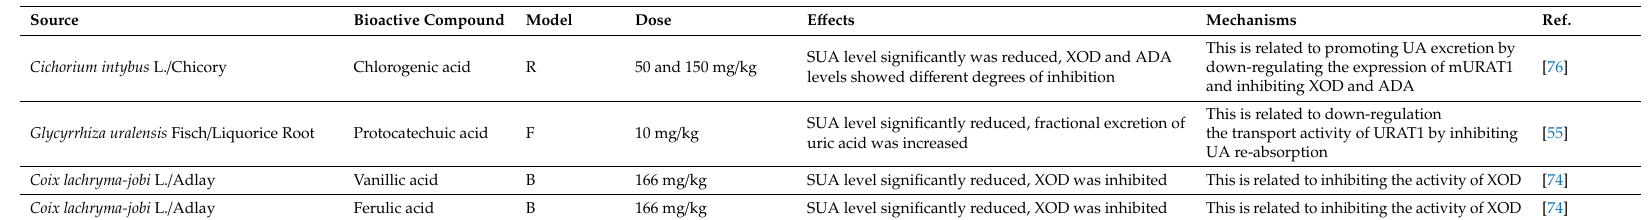
Table 4. Experiment and mechanism of phenolic acid bioactive components from plant-based functional foods on